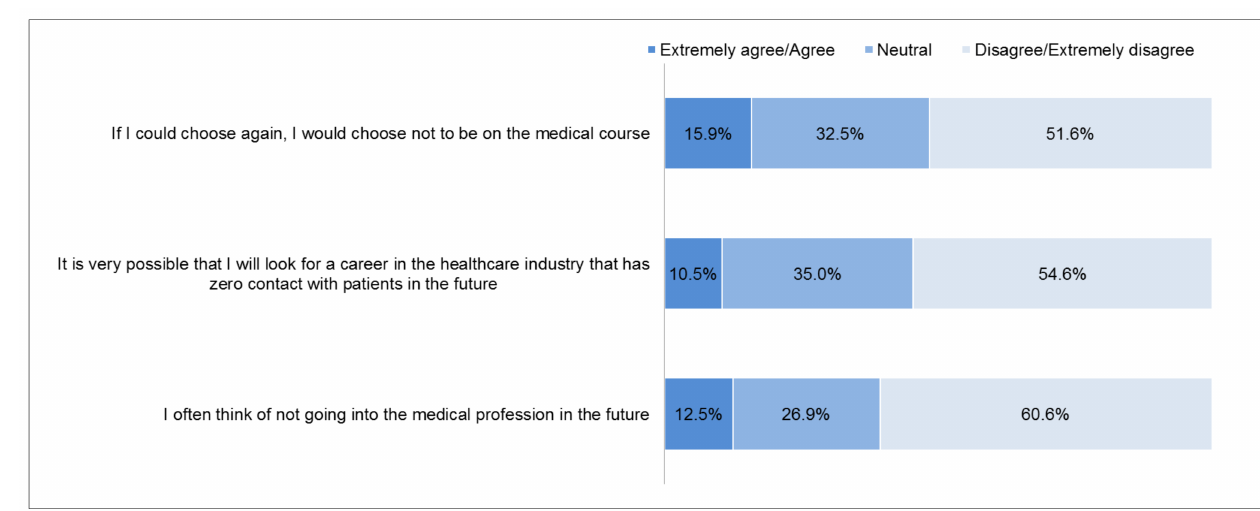
Figure 4. Proportion of responses for turnover items (N = 2922).